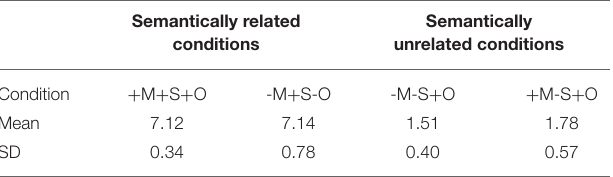
TABLE 1 | Descriptive statistics of the semantic relatedness ratings for the four experimental conditions. Semantically related